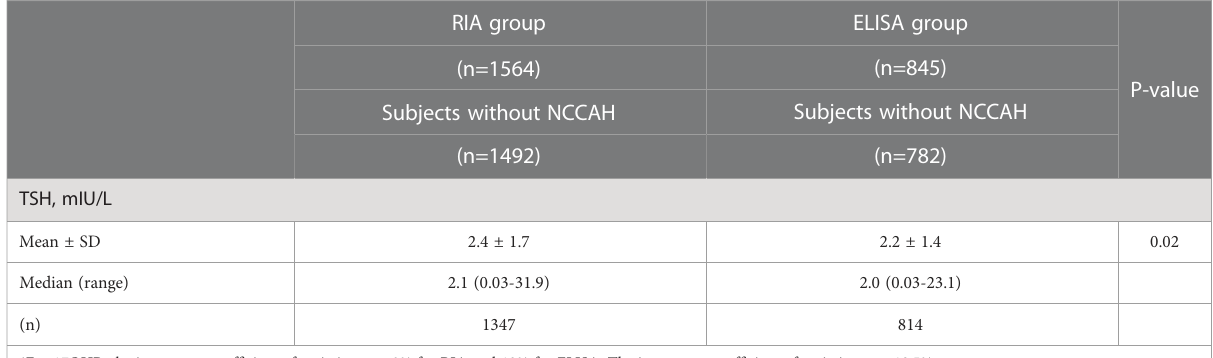
(Figure 2). When basal 17OHP cutoff value of 6.1 nmol/L was used in the ELISA group, sensitivity was 93.7% (p=1 for comparison with RIA), but speci fi city decreased to 84.5% (p<0.001 for comparison with